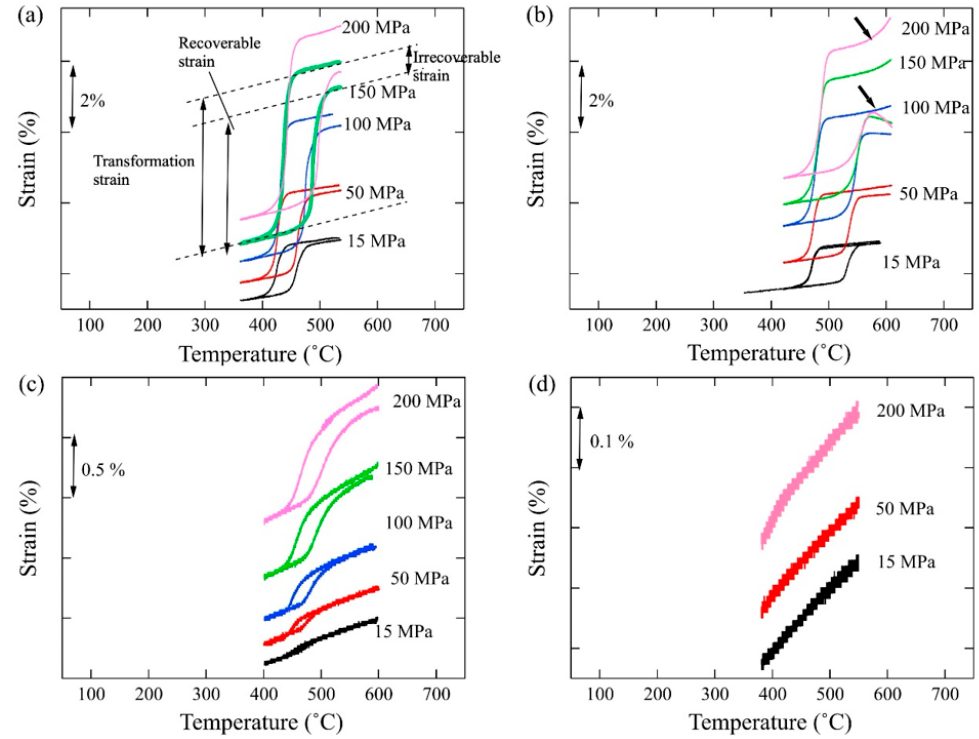
Figure 4. Strain–temperature curves of thermal cycle tests of between 15 and 200 MPa for ( a